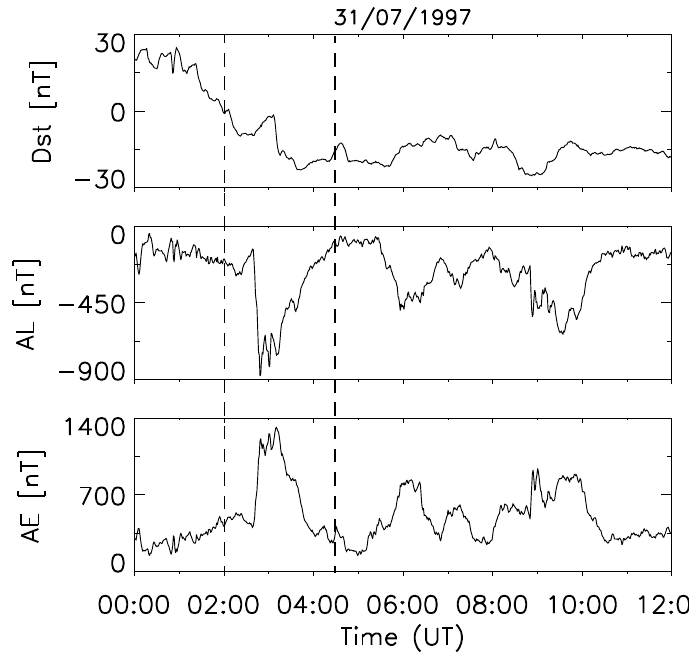
Fig. 8. The AE , AL and D st -indices between 00:00 and 12:00 UT on 31 July 1997. AE and AL are calculated from 67 stations between 55 and 76 ◦ in mag- netic latitudes. D st is calculated from 17 stations below 40 ◦ in magnetic lat- itudes. The two vertical dashed lines indicate our time interval with data be- tween 02:00 and 04:20